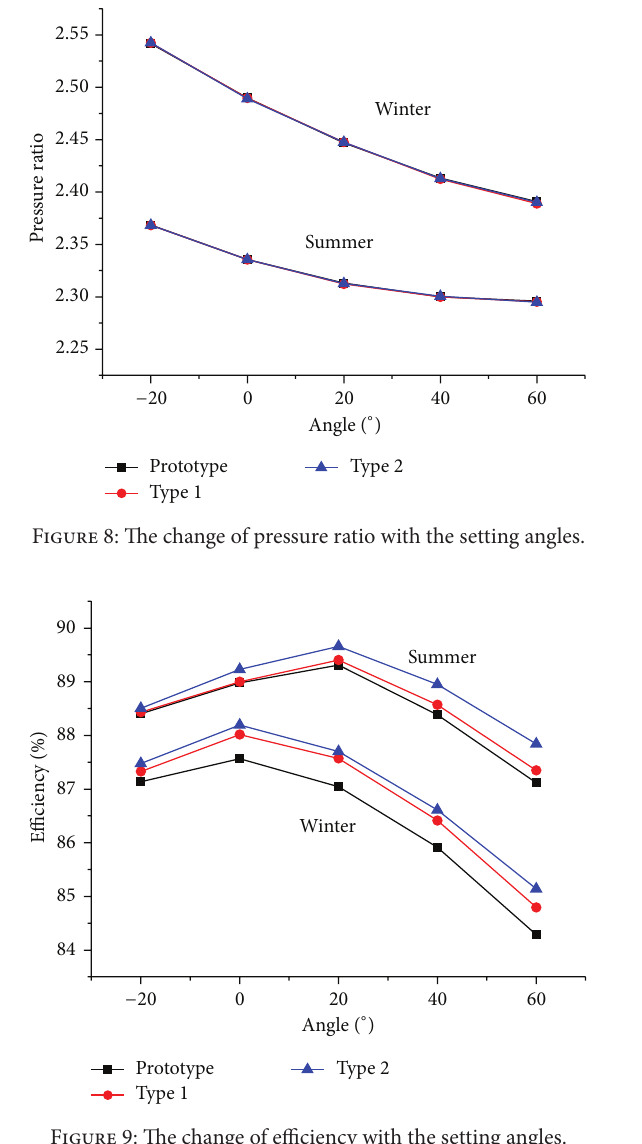
Figure 11: Velocity vector distribution of 0008 at 60 ∘ setting